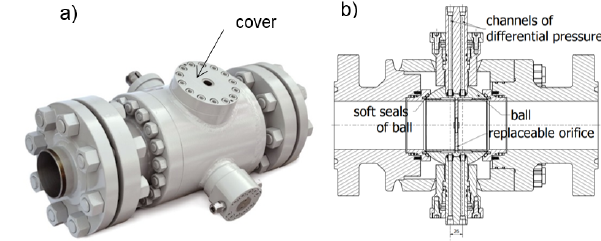
Figure 3: Valve prototype with measuring orifice a) view, b)